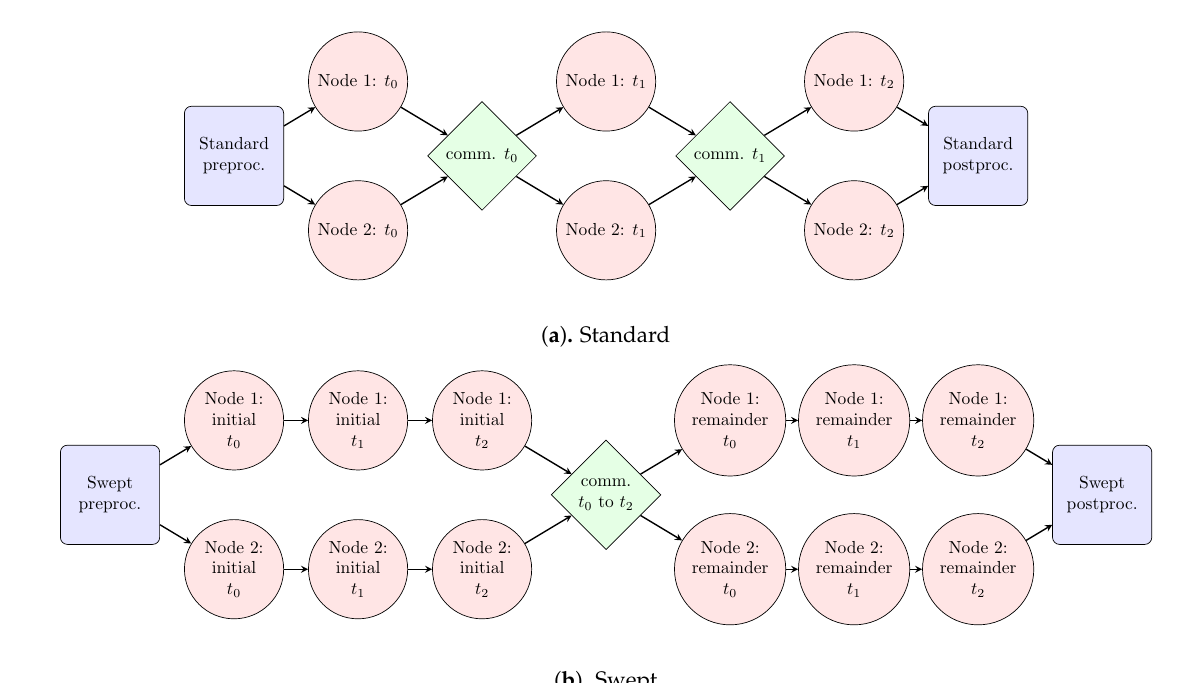
Figure 1. Process diagrams showing high-level views of the Standard and Swept solvers. Squares : pre- and postprocessing. Circles : calculation local to a node for a given time step. Diamonds : communication between nodes.